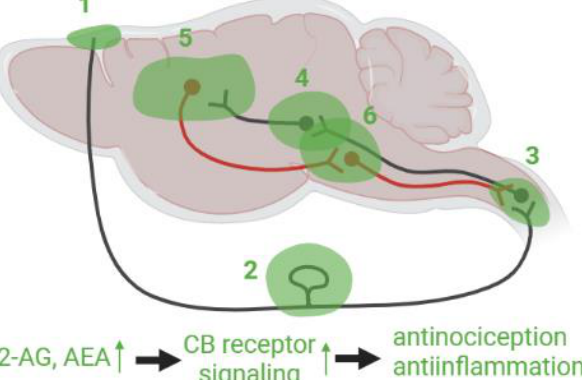
Figure 2. Hypothetical eCB mediated pain modulation in the PTH model. ECB signaling modulates nociceptive activation raised in TG neurons at (1) meninges by mast cells, macrophages and vascular cells, (2) TG with associated satellite glia cells, and (3) TNC. Nociceptive information ascends via the second order neurons innervating to (4) neurons in thalamus, amygdala, and other brainstem regions such as PAG where pain sensation was altered by CB receptor agonist or antagonist mi- croinjection. Subsequently it is transited to (5) cortical regions such as mPFC and insular cortex. It is possible that eCB signaling has a substantial modulatory function, for instance through amygdala- mPFC-PAG pathway. In descending pathway, eCB system is deeply involved in the modulation via (6) PAG and RVM, and in (3) TNC. These brainstem regions integrate and process both ascending and descending pain signals via eCB system modulation.